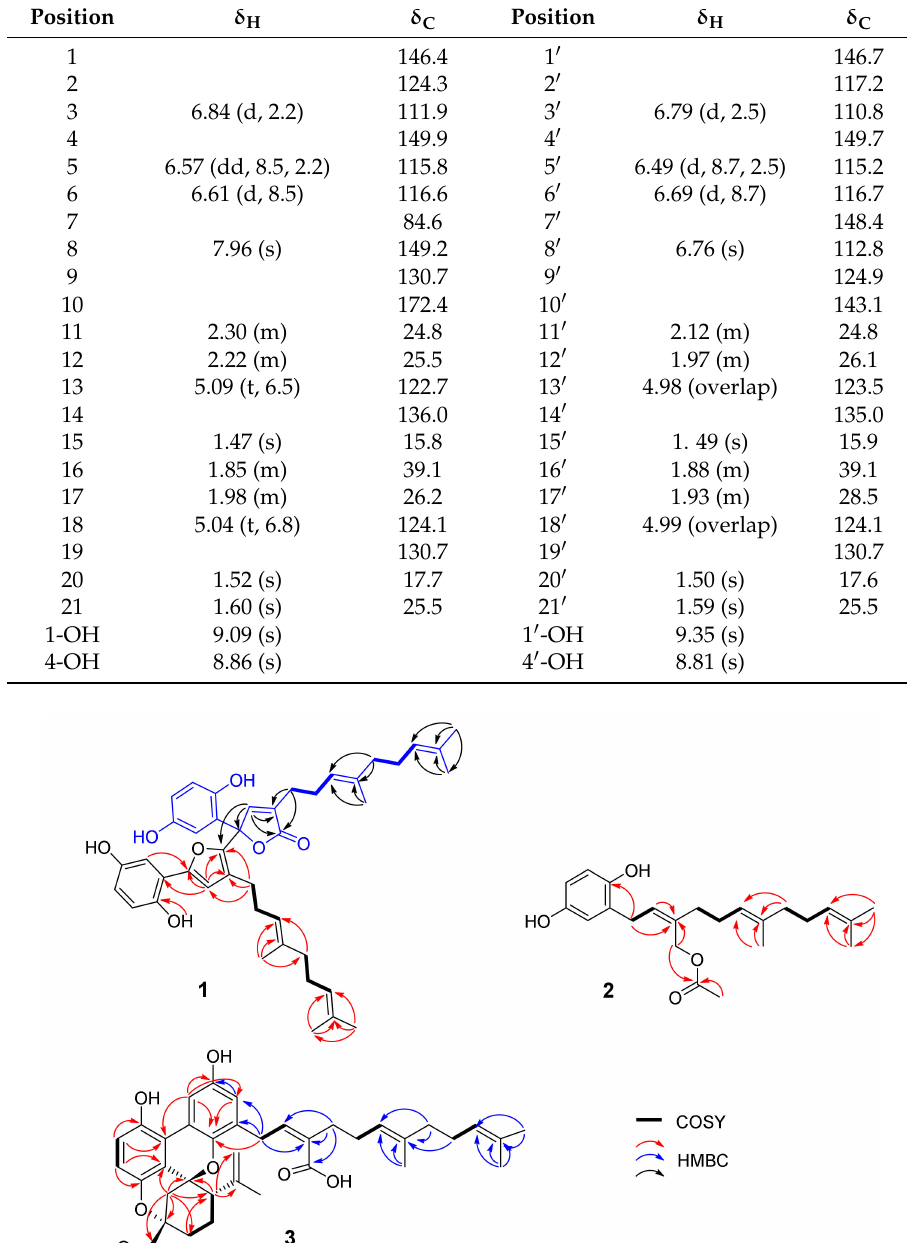
Table 1. 1 H- (600 MHz) and 13 C-NMR (150 MHz) data of 1 in DMSO- d 6 ( δ in ppm, J in Hz).